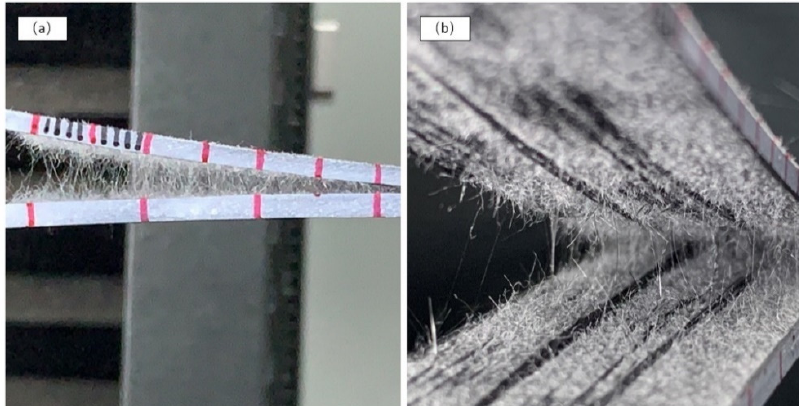
Figure 11. Failure mode of NVIC -ILT in DCB test. ( a ) side view, ( b ) through open mouth. J. Compos. Sci. 2020 , 4 , x